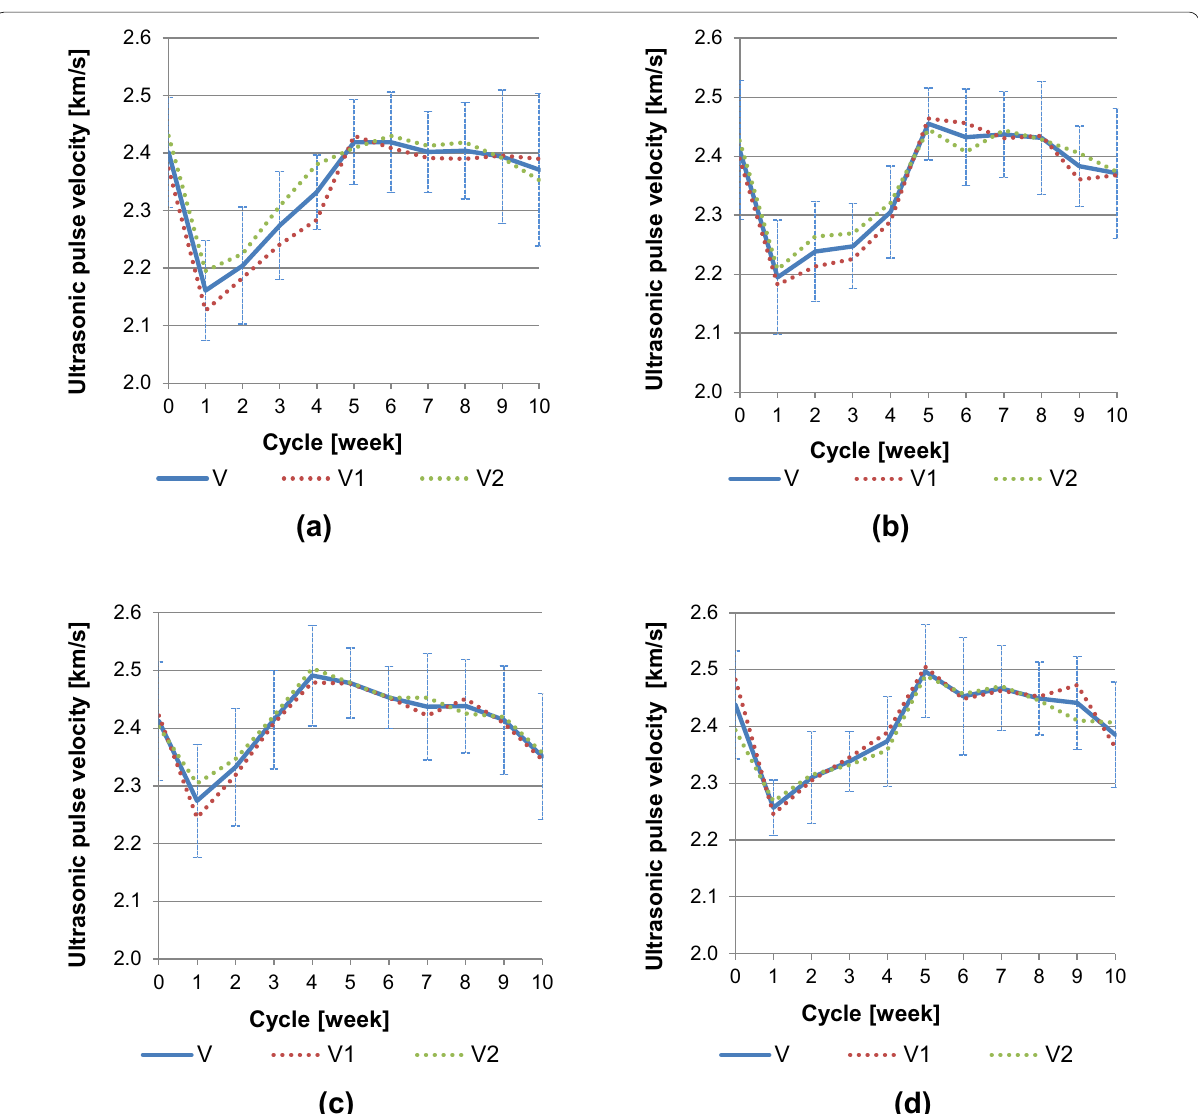
Fig. 14 Ultrasonic pulse velocity in cement-bonded particleboards exposed to environment according to EN 321 a REF; b LI10; c SW07; d